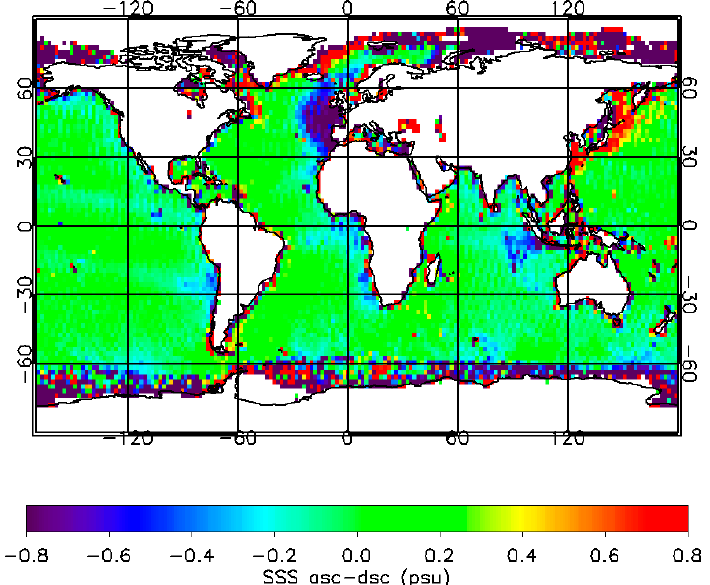
Figure 9. Map of the salinity difference between ascending (asc) and descending (dsc) Aquarius swaths for SEP 2011–AUG 2014.